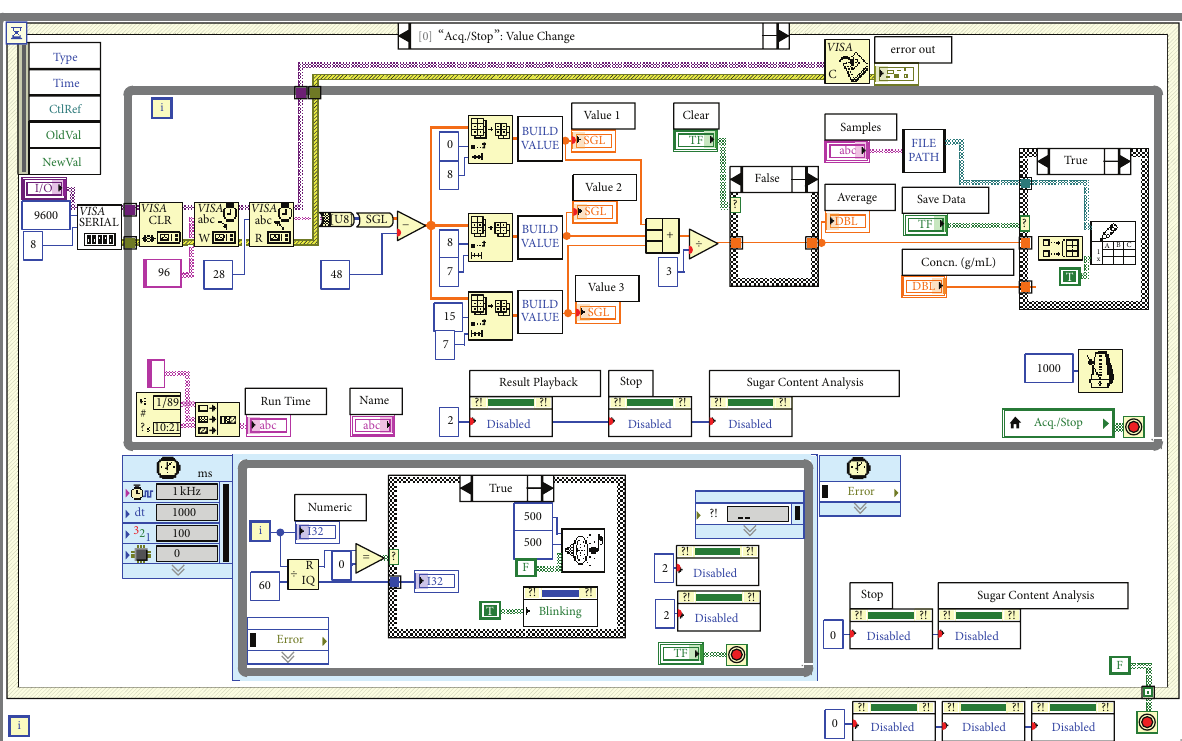
Figure 3: Program for the data